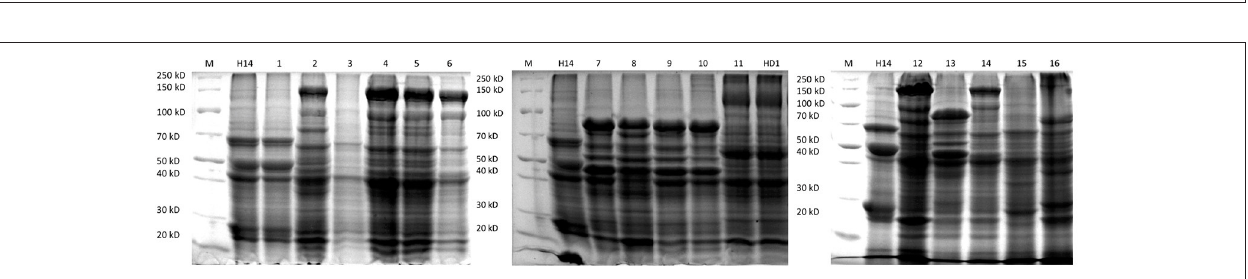
FIGURE 1 | Scanning electron microscopy images of the different types of crystal morphologies and the spores (S) produced by Bt strains of the collection. (A) Reference strain Bacillus thuringiensis israelensis H14 with smooth spherical [ss] crystal (B) Qatari Bti like isolate QBT229 with smooth spherical [ss] crystal (C) Spherical crystal with undulated surface [us] QBT240 (D) Spherical but deflated balloon [db] shape QBT34 (E) Spherical crystals with concave surface [cs] QBT81 (F) spherical crystals with pointy edges [pe] QBT99 (G) reference strain Bacillus thuringiensis kurstaki HD1 with bipyramidal [bp] and cuboidal [c] crystals (H) Qatari Btk like isolate QBT375 with bipyramidal [bp] and cuboidal [c] crystals.